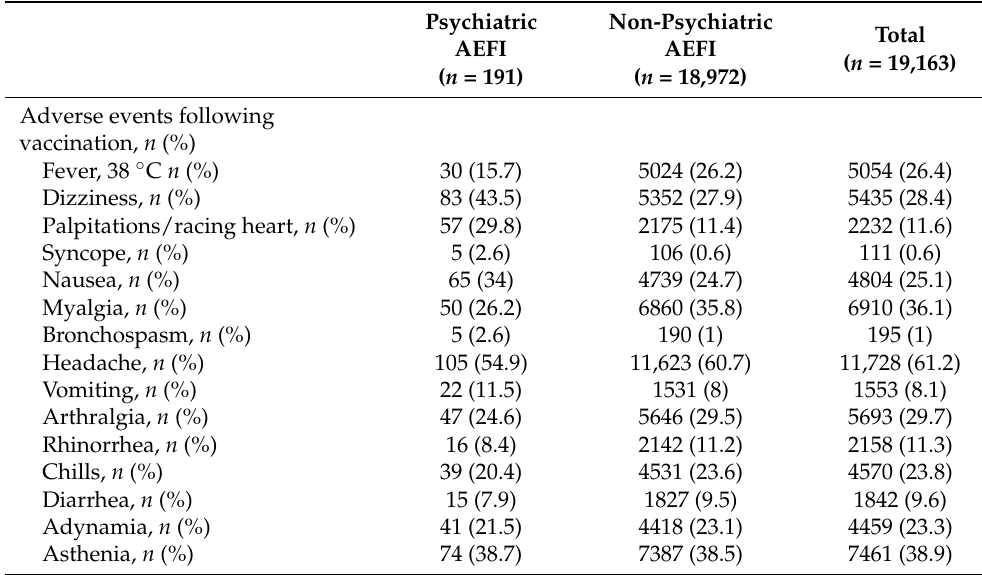
Table 2. Adverse events following vaccination according to the development of psychiatric events.